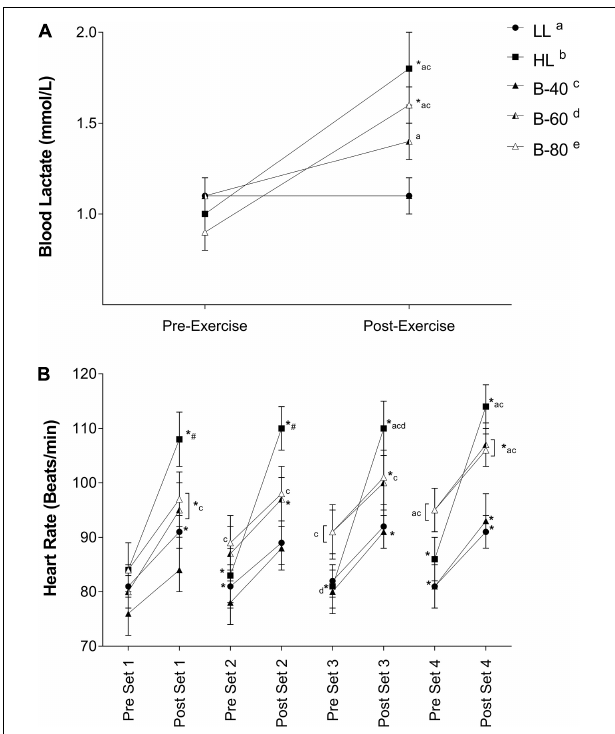
FIGURE 5 | (A) Blood lactate concentrations and (B) Heart rate during all five trials [heavy load (HL), light load (LL), 40% limb occlusion pressure (B-40), 60% limb occlusion pressure (B-60), 80% limb occlusion pressure (B-80)]. Values are presented as mean ± SEM. ∗ Indicates a significant difference from previous time point. Lower case letters (see legend) represent a significant difference between trials at a time point. # Indicates a significant difference from all trials at a time point. Significance set at p <